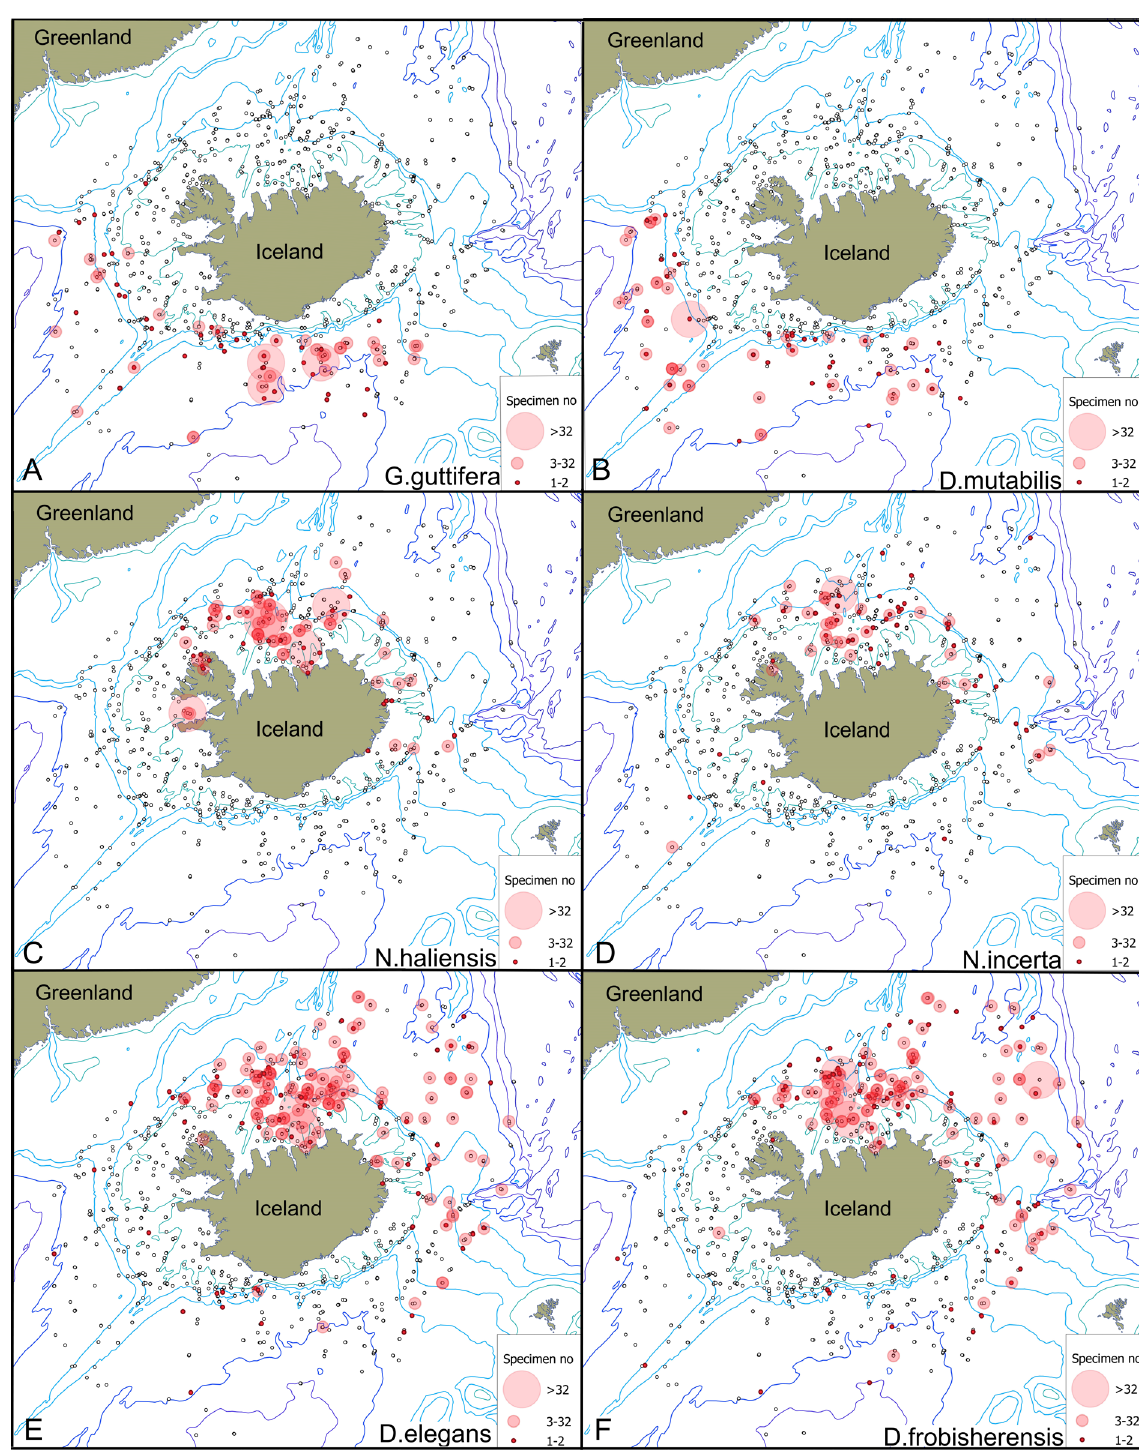
Fig. 19. Species distributions based on BIOICE samples (Icelandic waters). A . Grigelis guttifera (d’Orbigny, 1846) comb. nov. B . Dentalina mutabilis (Costa, 1855). C . Nodosaria haliensis Eiland & Gudmunðsson, 2004. D . Nodosaria incerta Neugeboren, 1856. E . Dentalina elegans d’Orbigny, 1846. F . Dentalina frobisherensis Loeblich & Tappan,